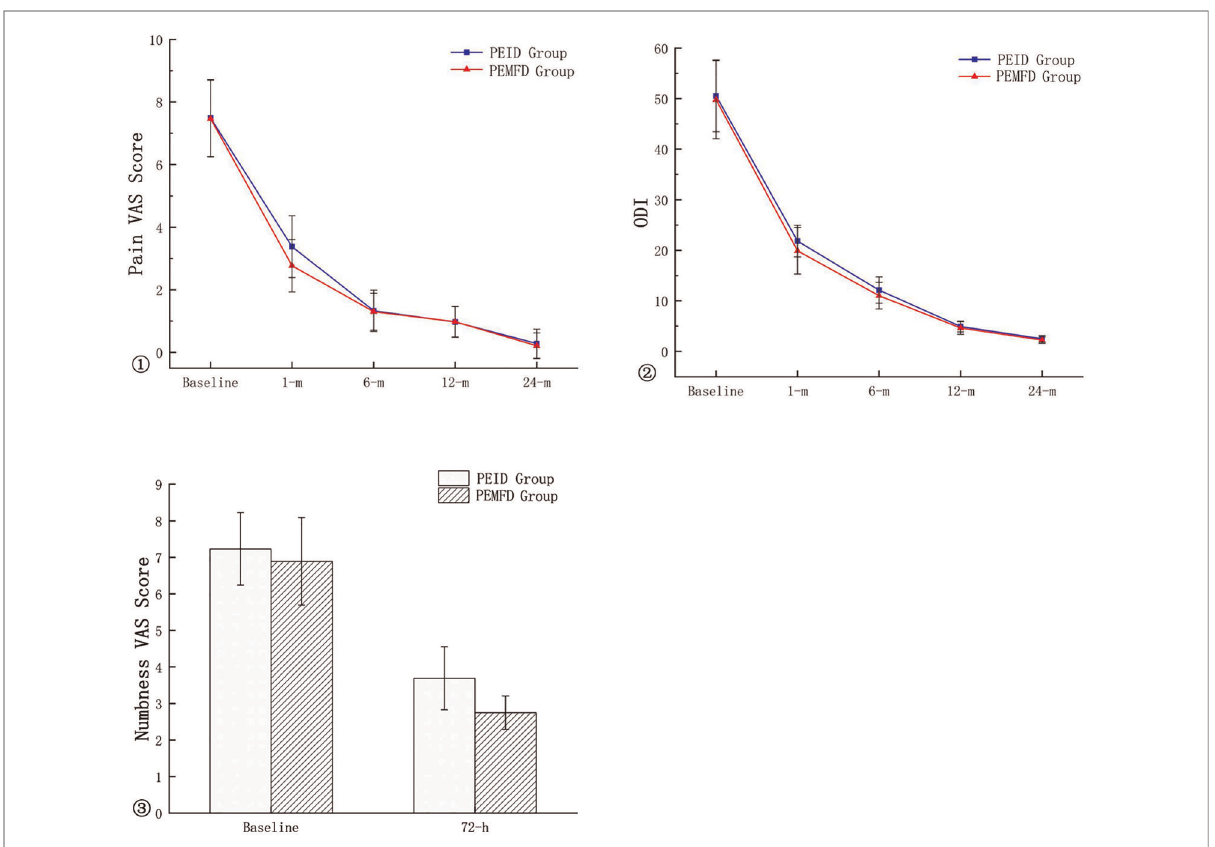
FIGURE 5 Comparison of pain, numbness VAS and oswestry disability Index scores between groups.